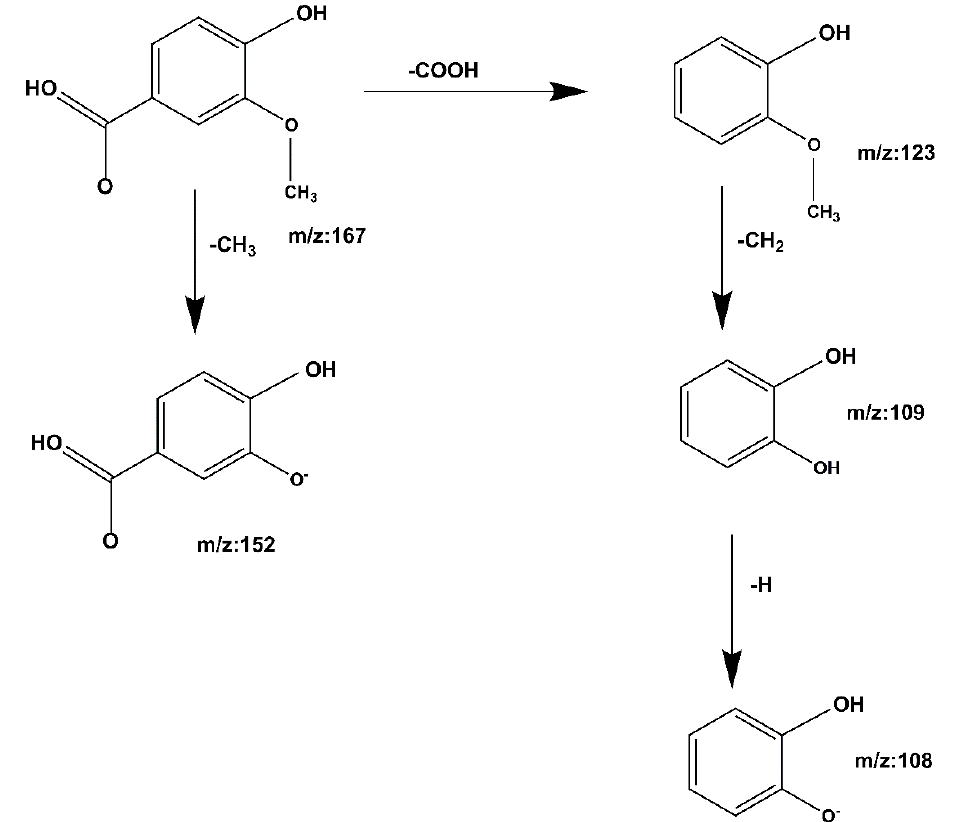
11. It was identified as ferulic acid by comparing it to the Mass Bank database and the Figure 10. Vanillic acid cleavage pathway demonstrated by mass spectrometry Figure 10. Vanillic acid cleavage pathway demonstrated by mass spectrometry. reference literature [31,33]. Compound 5 Ferulic acid: The quasi-molecular ion peak was detected at [M − H] − m / z 193.05, and the chromatographic retention time was 13.4 min. Consequently, m / z 193.05 produces fragments m / z 177 and m / z 149 after the removal of H 2 O and CH 2 O 2 . The loss of CH 3 at m / z 149 results in fragment m / z 134. The cracking process is shown in Figure